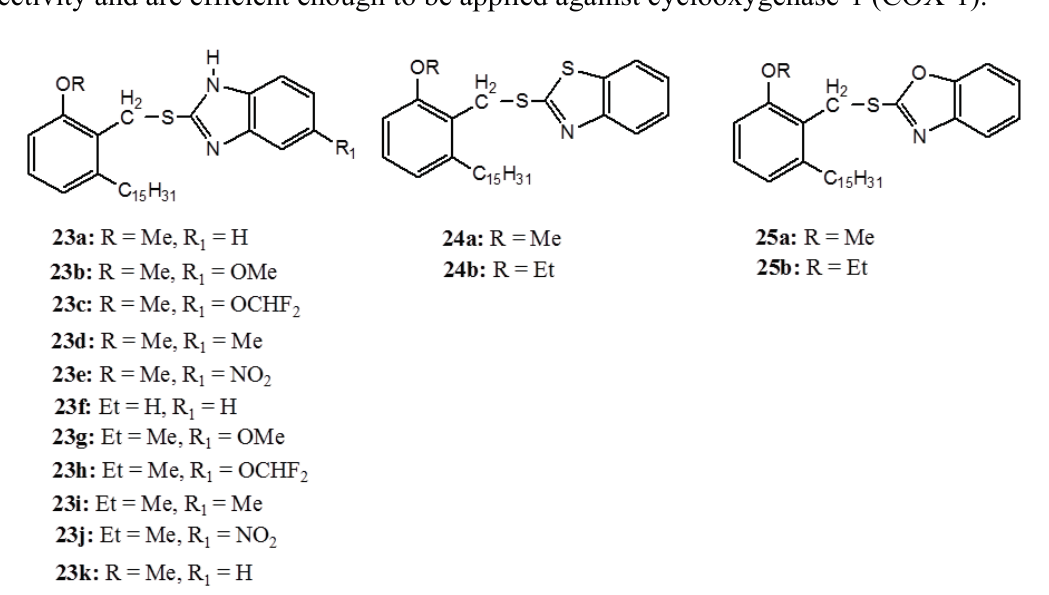
Figure 9. The benzimidazole ( 23a – k ), benzothiazole ( 24a – b ) and benzoxazole ( 25a – b ) derivatives.